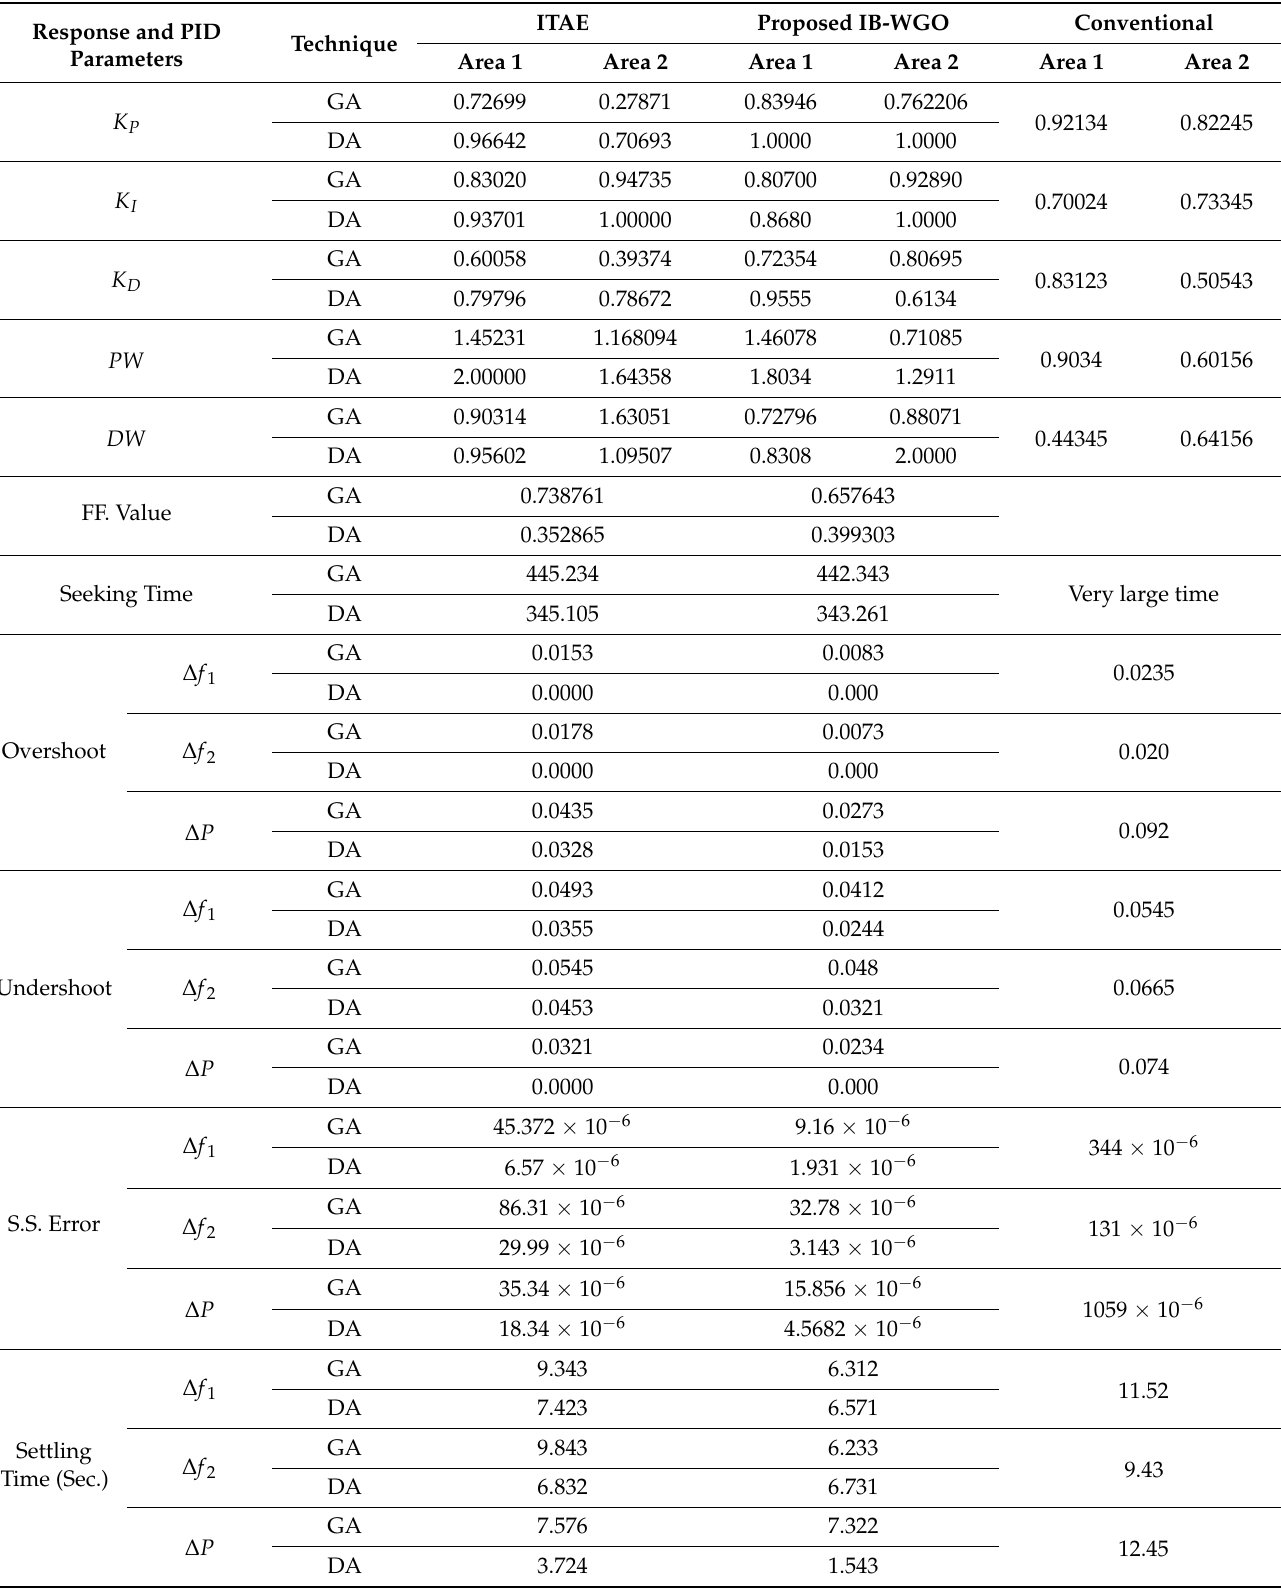
Table 8. Efforts using conventional 2DOF-PID, DA-2DOF-PID-ITAE, and GA-2DOF-PID-ITAE, and